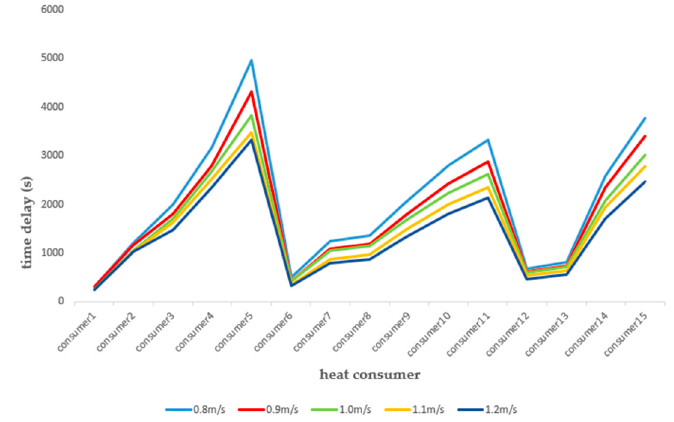
Figure 9. The time delay of each heat consumer under five different flow rates.